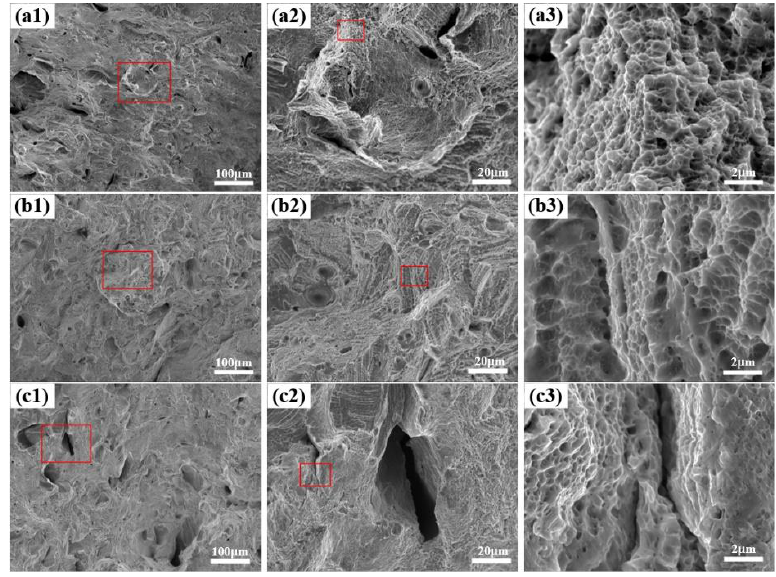
Figure 12. The fracture morphology: ( a ) 60 J·mm −3 ; ( b ) 96 J·mm −3 ; ( c ) 119 J·mm −3